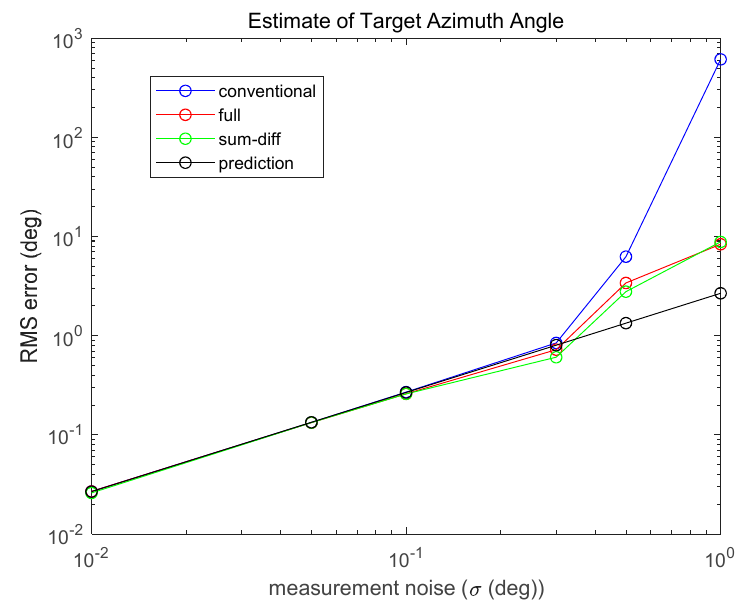
Figure 4. Three position vectors and true anomalies.